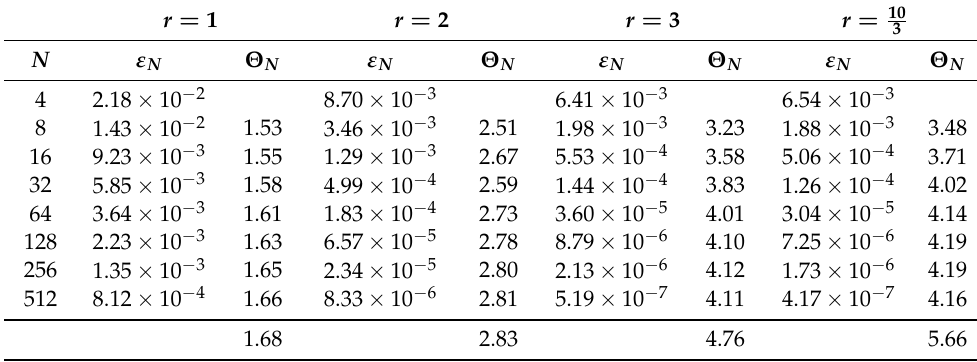
Table 3. Numerical results for problem (65) and (66) with m = 2 and η 1 = 0.1, η 2 =